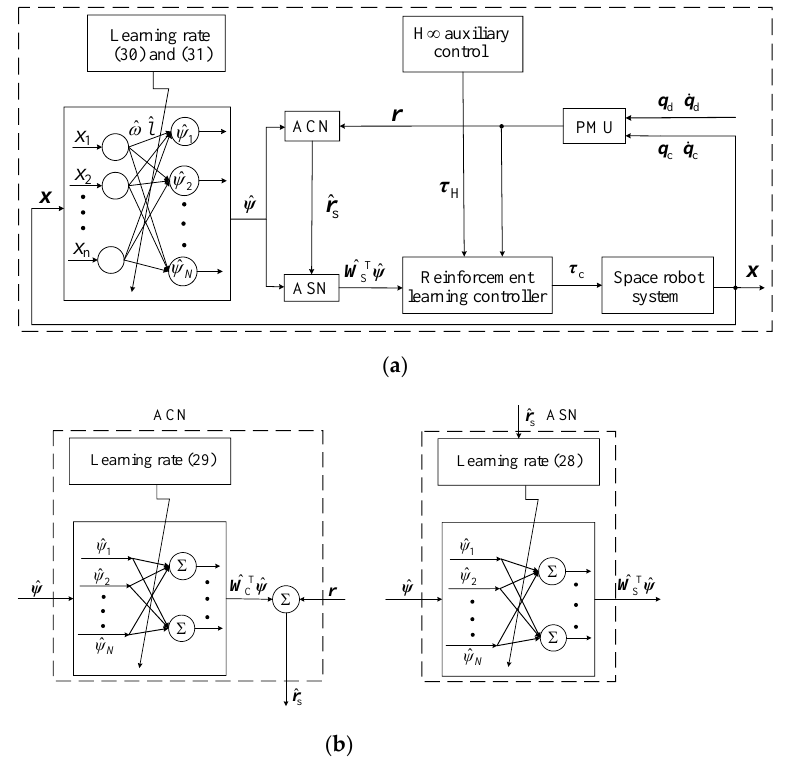
Figure 4. The control block diagram based on fuzzy logic Reinforcement Learning. ( a ) The overall control block diagram; ( b ) The ACN and ASN unit.